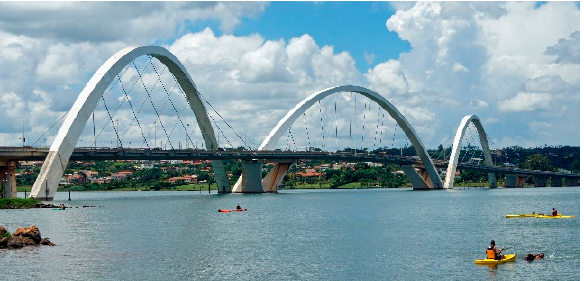
Figure 12. Juscelino Kubitschek Bridge (Photo: Mariordo, Wikimedia Commons).